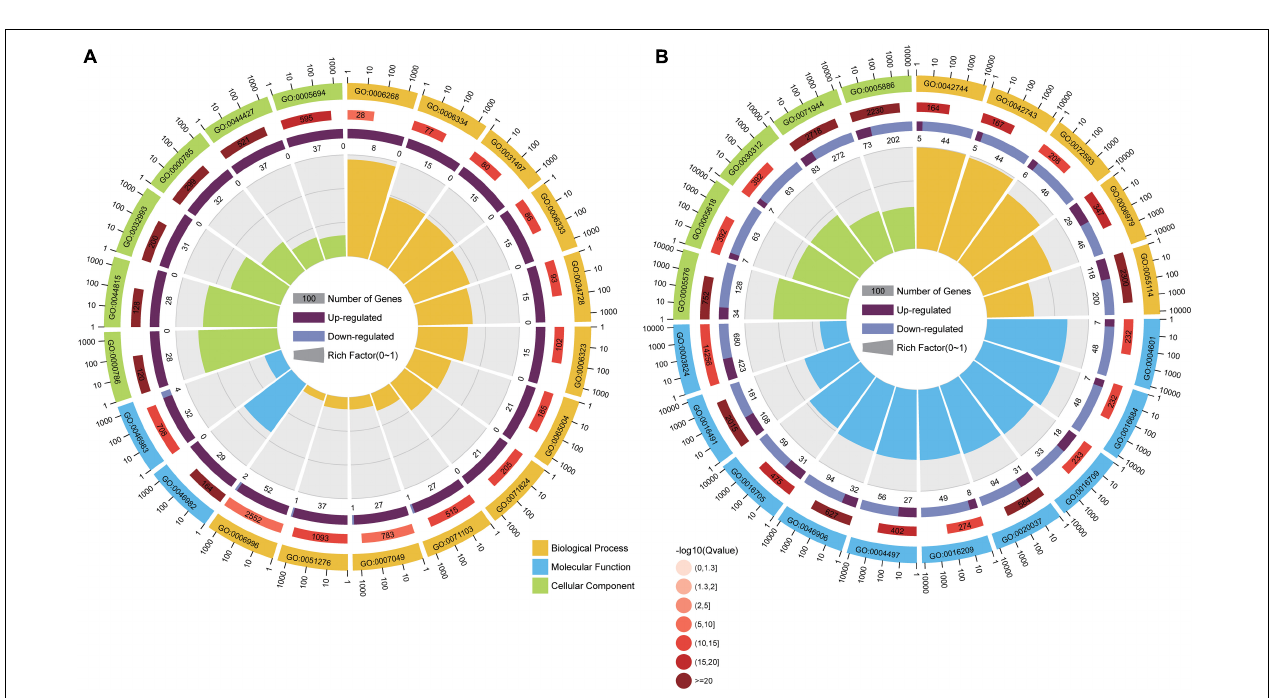
FIGURE 2 | Heatmap of the Pearson’s correlation coefficients from comparisons between CK, T2, and T3 samples (A) . Differentially expressed genes (DEGs) in different comparison groups, i.e., CK vs. T2 and CK vs. T3 (B) .